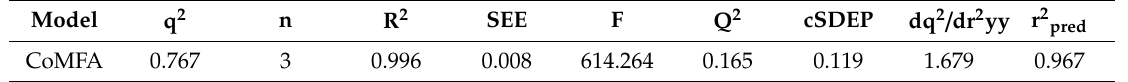
Table 3. Double-activity 3D-QSAR model parameters of QNs biotoxicity.